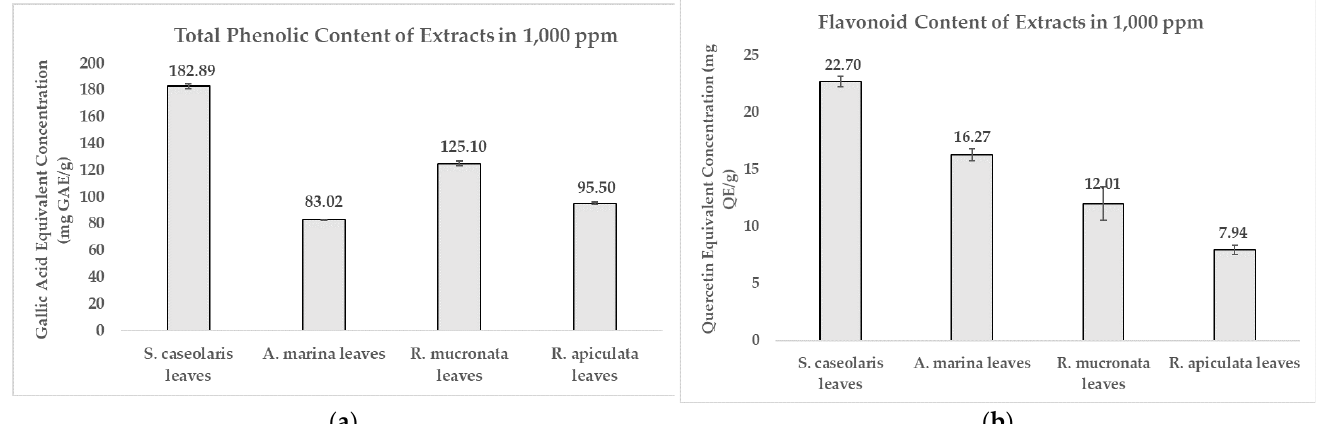
Figure 2. Comparison of: ( a ) Total Phenolic Content; ( b ) Flavonoid Content of various local mangrove species extracts dissolved in 1000 ppm. Result values and error bars were plotted in the form of mean ± standard deviation, respectively.